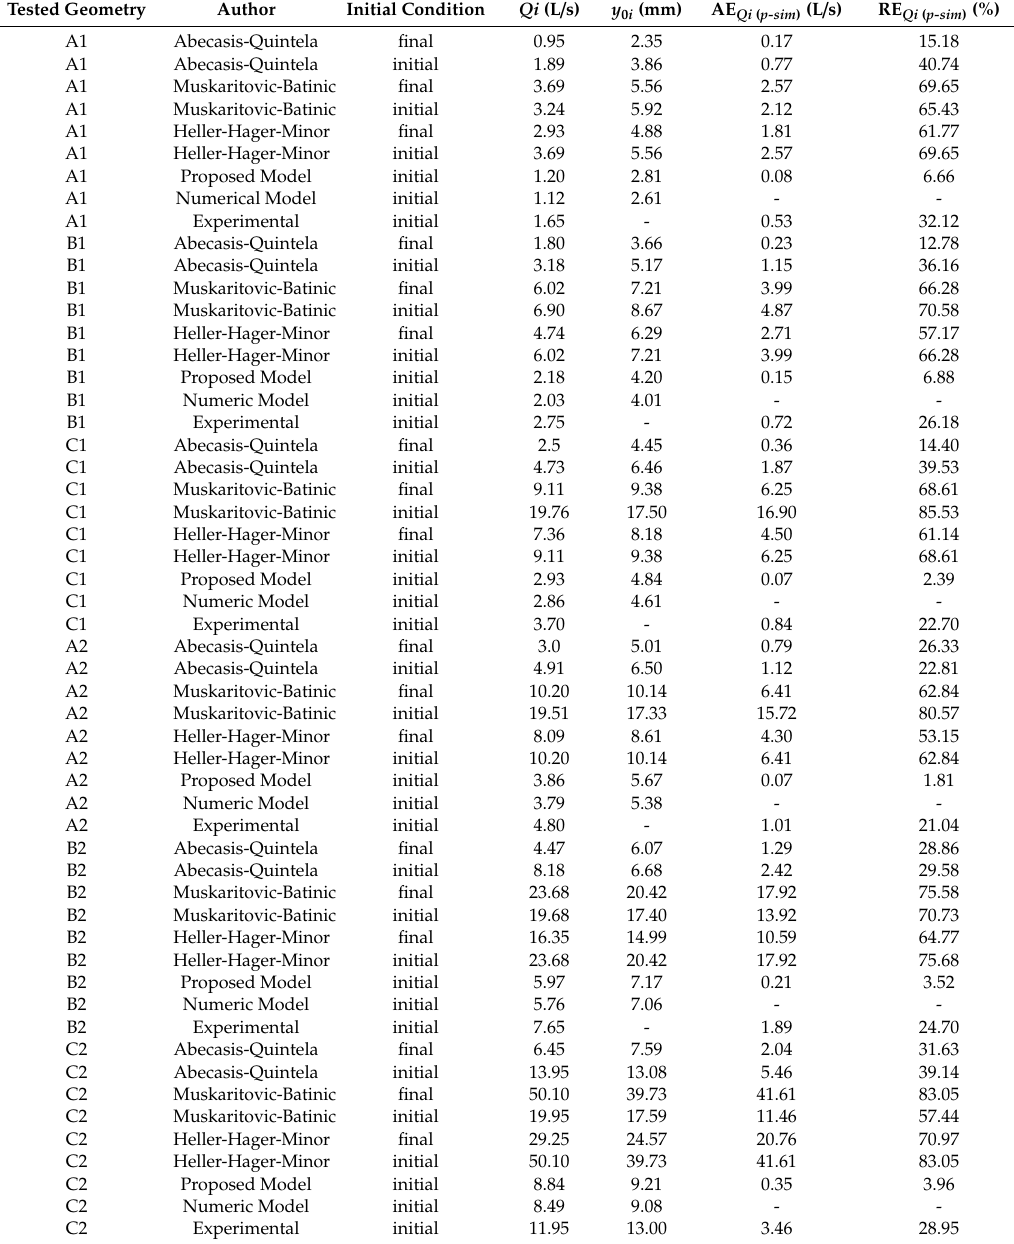
Table 13. Flow rate for the initiation of the jet flow Qi and flow depth at the lowest point of the flip bucket y 0 i obtained using the formula of di ff erent authors, by means of the proposed formula and by numerical simulation Absolute Error and Relative Error, taking as the reference the flow rate obtained with the numerical simulation Qi sim